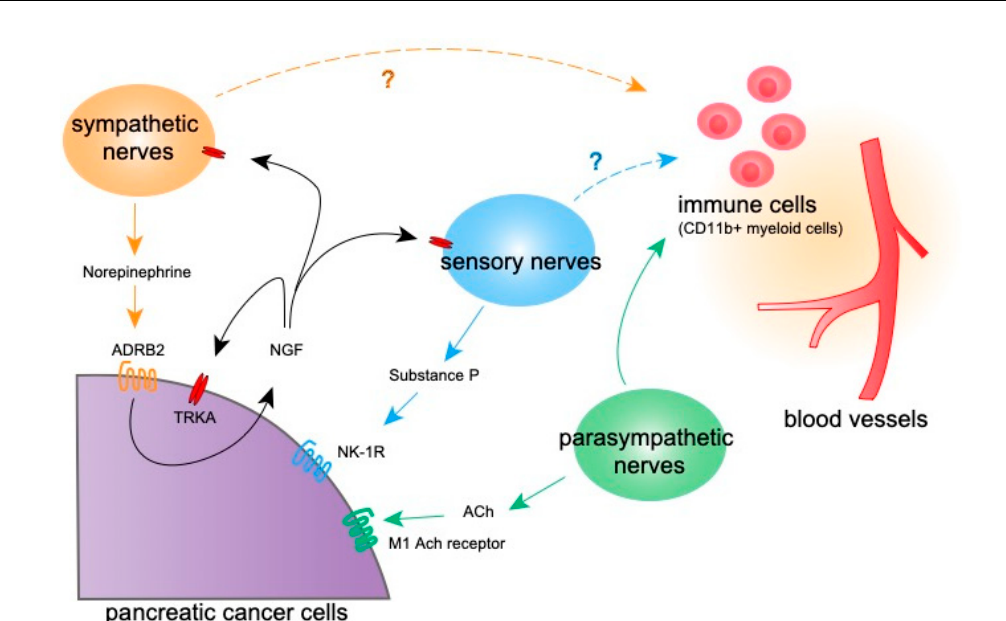
Figure 2. The signaling from nerves into pancreatic tumor microenvironment. A schematic figure showing signaling molecules from various nerves into pancreatic cancer cells and other components in the tumor microenvironment to regulate tumor progression. ADRB2, beta 2 adrenergic receptor. Ach, Acetylcholine. Question marks indicate effects reported in cancers other than PDAC. Table 1. Molecules secreted by nerves and their effects on target cells.